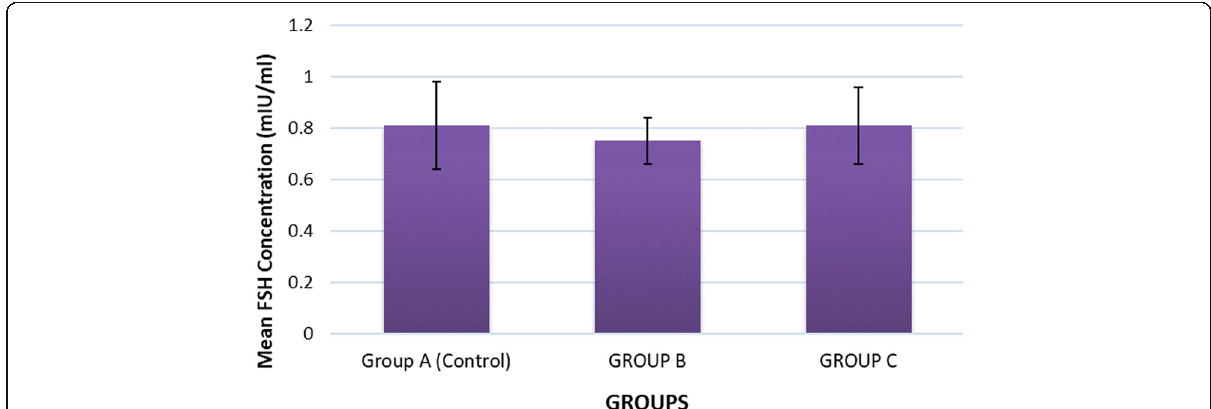
Fig. 4 Effect of perinatal β -cyp exposure on serum FSH concentration of female F1 generation rats at sexual maturity. Results are given as mean ± SEM for 5 rats in each group. Experimental groups are compared with group A (control). No significant difference at a 95% confidence interval ( p > 0.05). Groups A, B, and C represent the control (given 0.5 ml olive oil), 15 mg/kg β -cyp-treated rats, and 30 mg/kg β -cyp-treated rats,